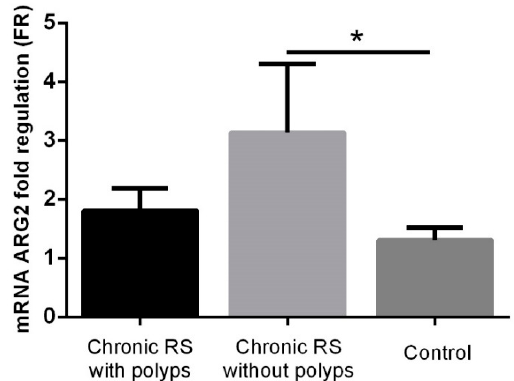
Figure 3. ARG2 expression in the group with chronic rhinosinusitis (RS) (with or without polyps) and in the control group. * p < 0.05.